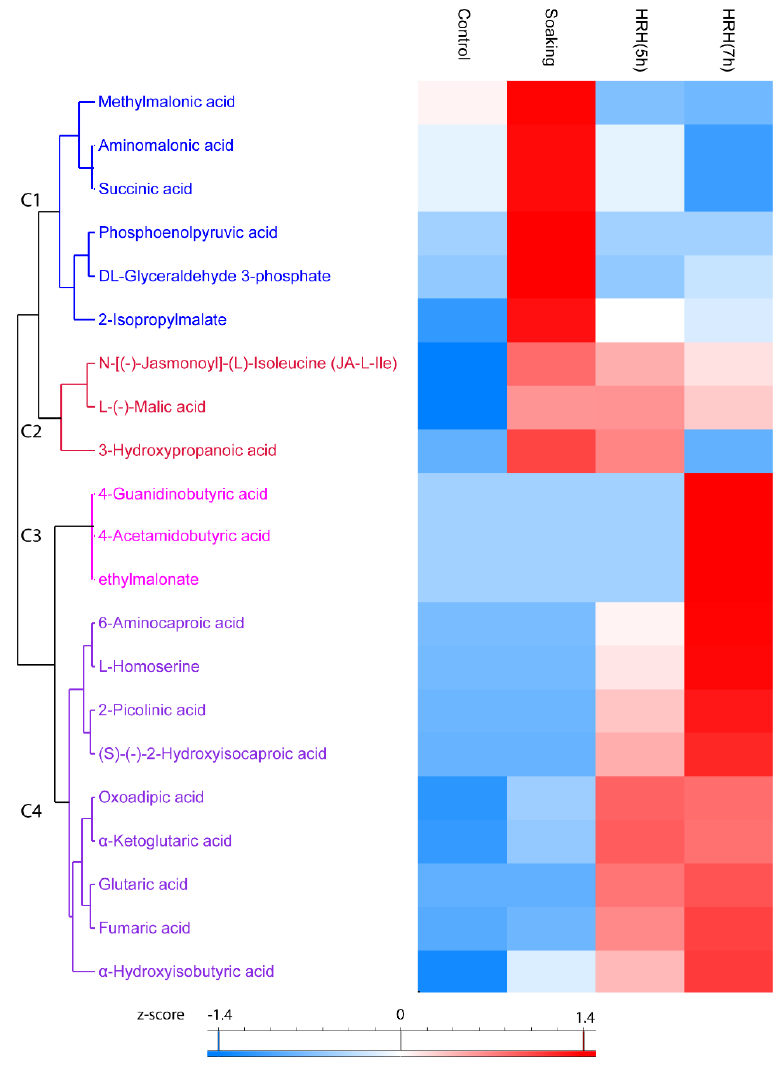
Figure 5. Hierarchical cluster analysis based on peak area of organic acids. C1 – C4: Cluster 1 – 4.